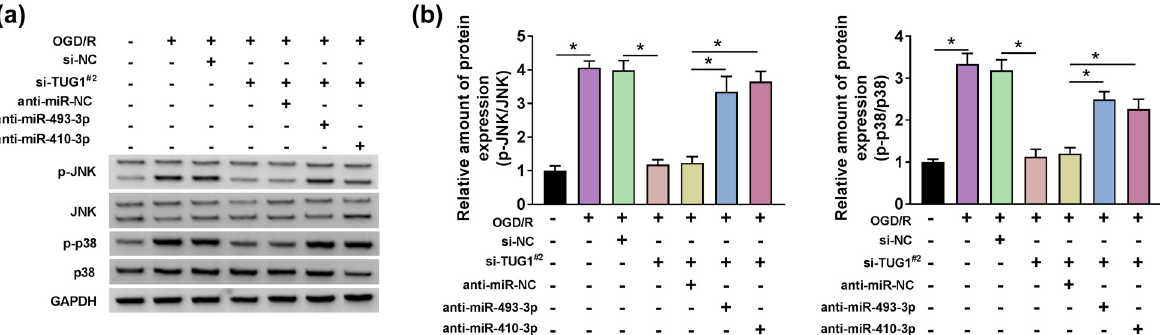
Figure 7: The inhibition of miR - 493 - 3p or miR - 410 - 3p could restore the reverse e ff ects of TUG1 knockdown on OGD/R - mediated activation in p - JNK/JNK and p - p38/p38 pathway in N2a cells in vitro . ( a and b ) The protein expression of p - JNK, JNK and p - p38, p38 was measured by western blot in N2a cells, which transfected with si - TUG1 #2 + anti - miR - 493 - 3p or si - TUG1 #2 + anti - miR - 410 - 3p or negative controls, with or without being treated by OGD/R. * P <